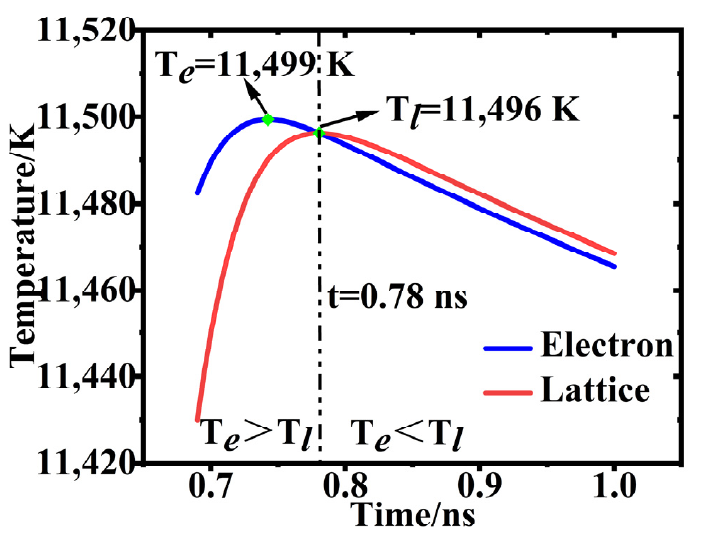
Figure 9. Variation of electron and lattice temperatures in the time domain; the inset shows a local enlarged view.